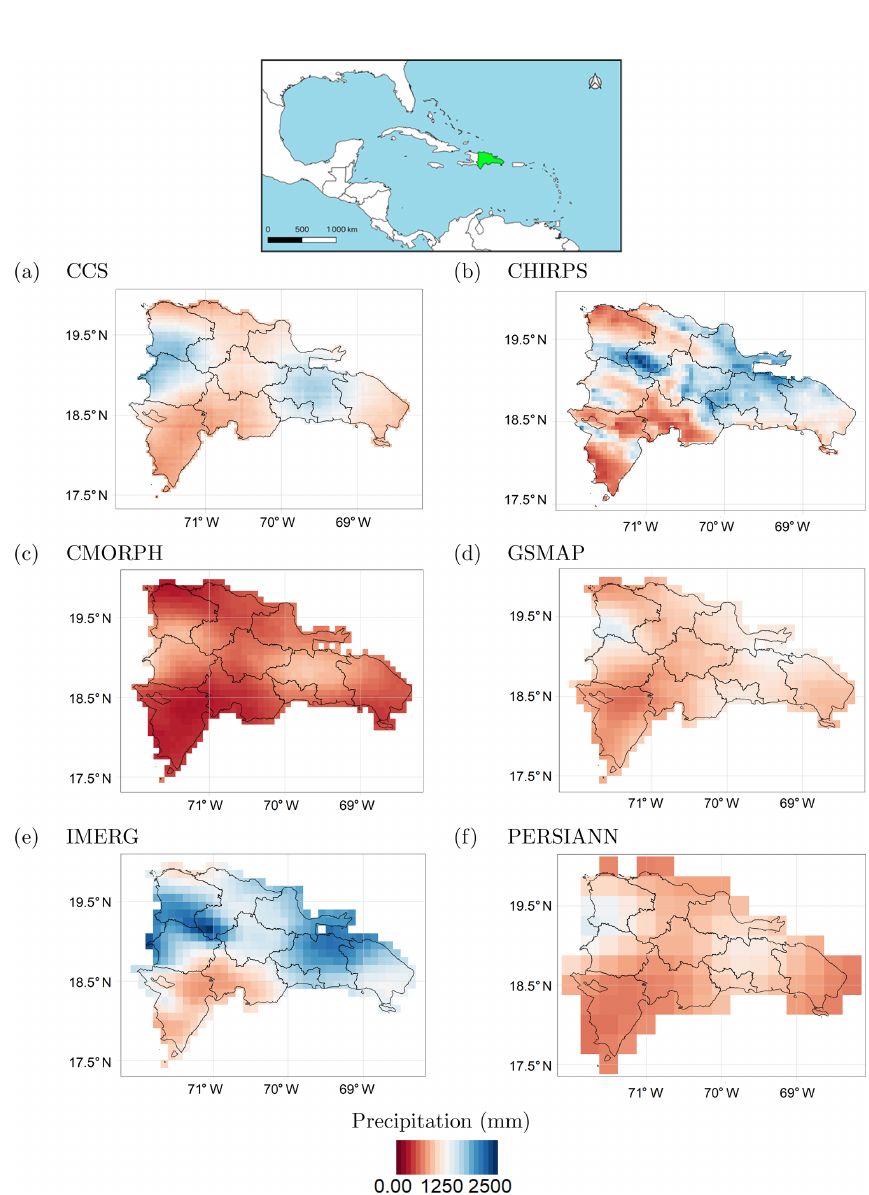
Figure 5. Average annual rainfall over the Dominican Republic according to the six considered datasets. (a) CCS, (b) CHIRPS, (c) CMORPH, (d) IMERG, (e) GSMaP and (f)